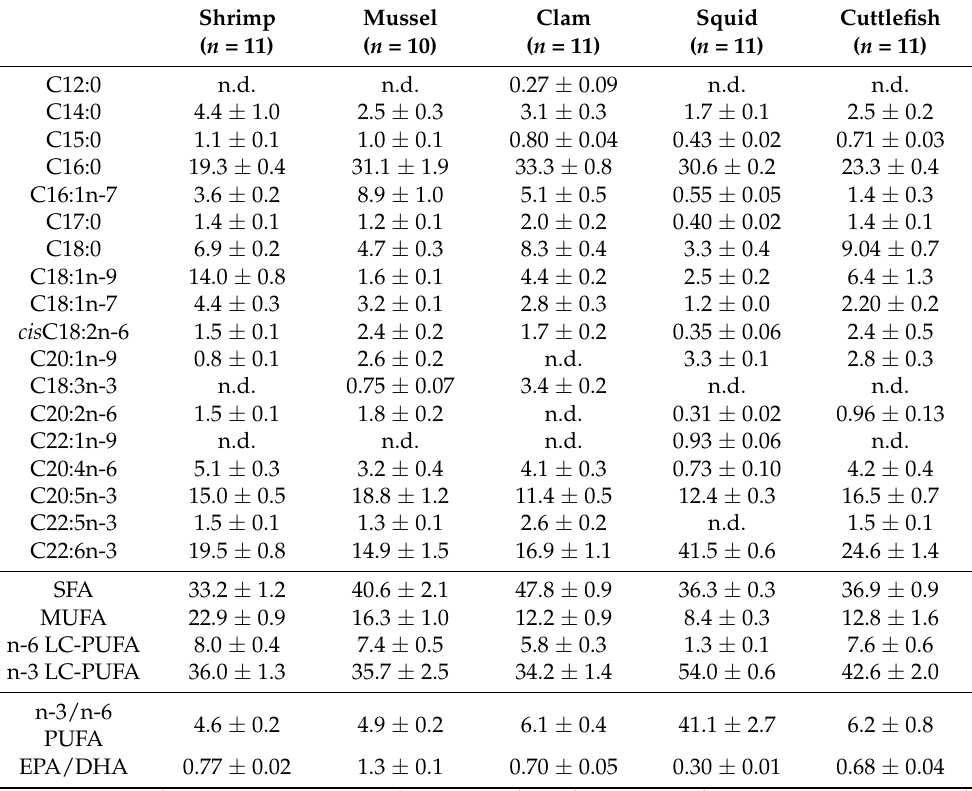
Table 4. Percentages of fatty acids in fresh mollusks and crustaceans usually consumed in Spain. Shrimp ( n = 11)